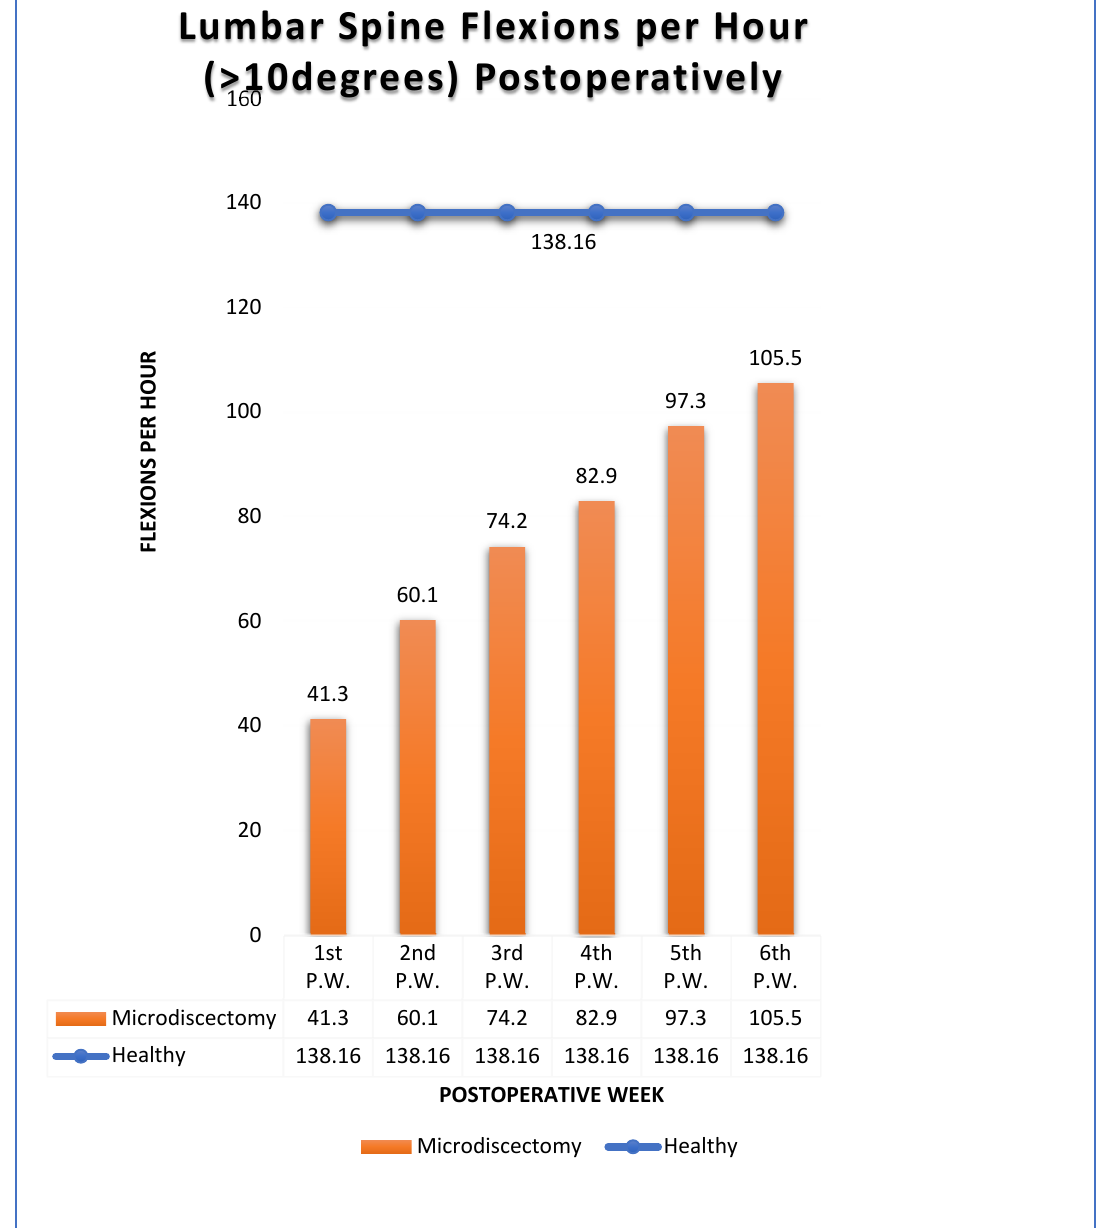
Figure 11. Results presenting the number of lumbar spine flexions (more than 10 degrees) for healthy subjects (blue line) and operated patients (orange bars).